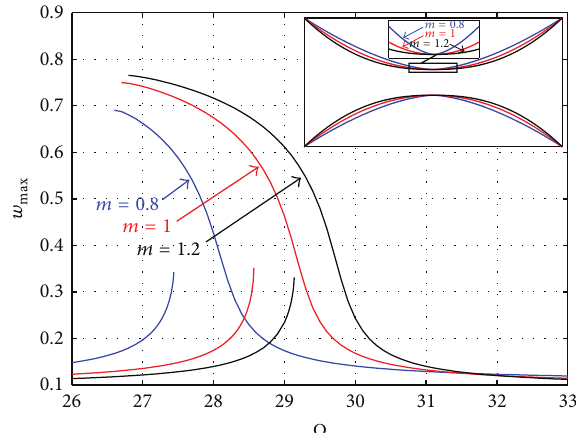
Figure9:Comparisonofdynamicresponsecurvesofdifferentmax- imum width 𝛼 .